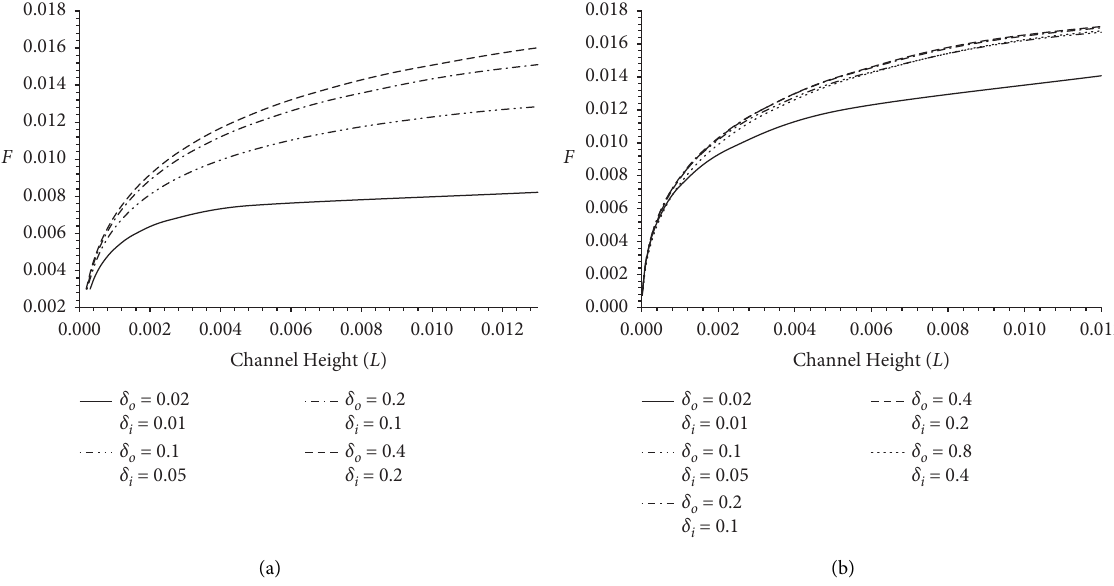
Figure 11: Induced flow rate versus channel height for different δ